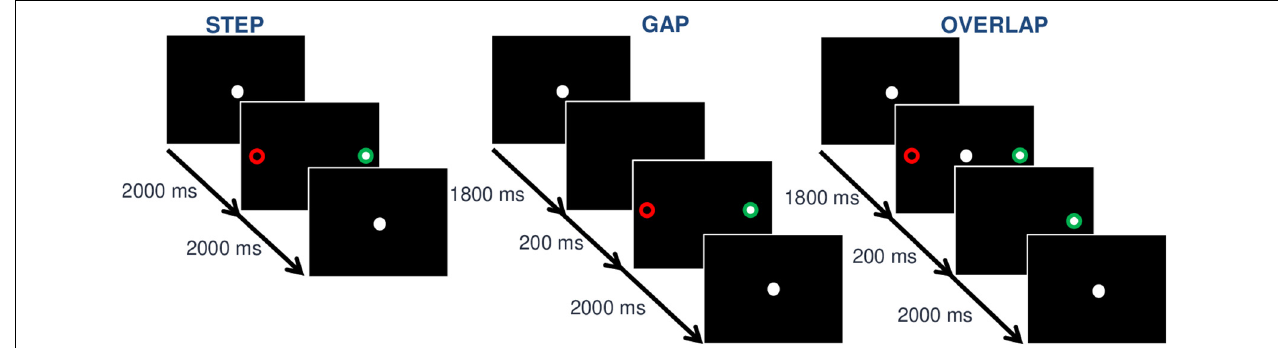
FIGURE 1 | Illustration of the gap, step, and overlap conditions in a paradigm of prosaccade (PS) and antisaccade (AS). The ◦ represents the point displayed, ◦ the optimal fixation in the AS task, and ◦ the optimal fixation in PS task. In the step condition (left), the central dot disappears simultaneously with the target dot appearance. In the step condition (left), the central dot simultaneously disappears when the target appears. In the gap condition (middle), the central dot disappears 200 ms before the target dot appears. In the overlap condition (right), the central dot disappears 200 ms after the target dot